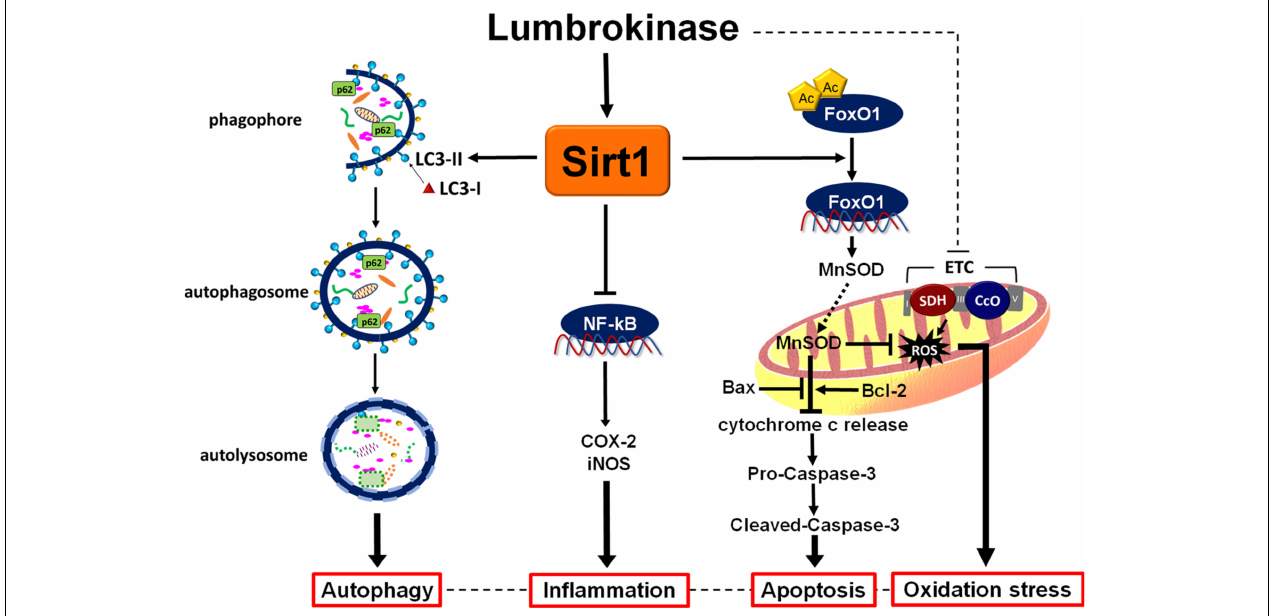
FIGURE 9 | Schematic diagram of the effects of post-ischemic lumbrokinase treatment in myocardial I-R injury. Post-ischemic lumbrokinase treatment attenuates myocardial I-R injury through the activation of Sirt1 signaling, inhibition of NF- κ B expression and activation of FoxO1 and LC3, and thus reduces inflammation, oxidative stress and apoptosis, and enhances autophagy after myocardial I-R